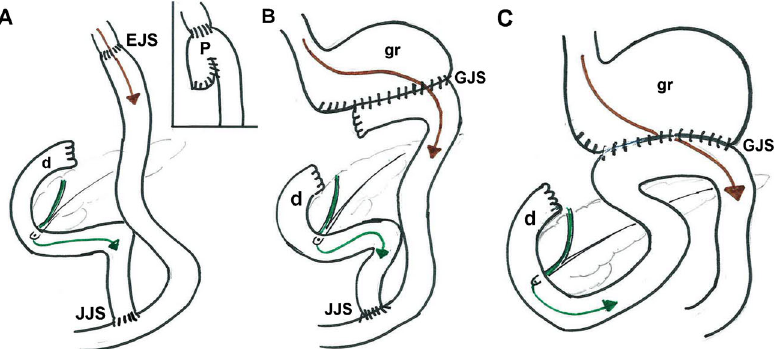
arrow, bile flow in dark green. B) after subtotal gastrectomy with small- sized gastric remnant (gr) connected to Roux-en-Y gastrojejunostomy (GJS). C) after partial gastrectomy reconstructed with a Billroth II GJS